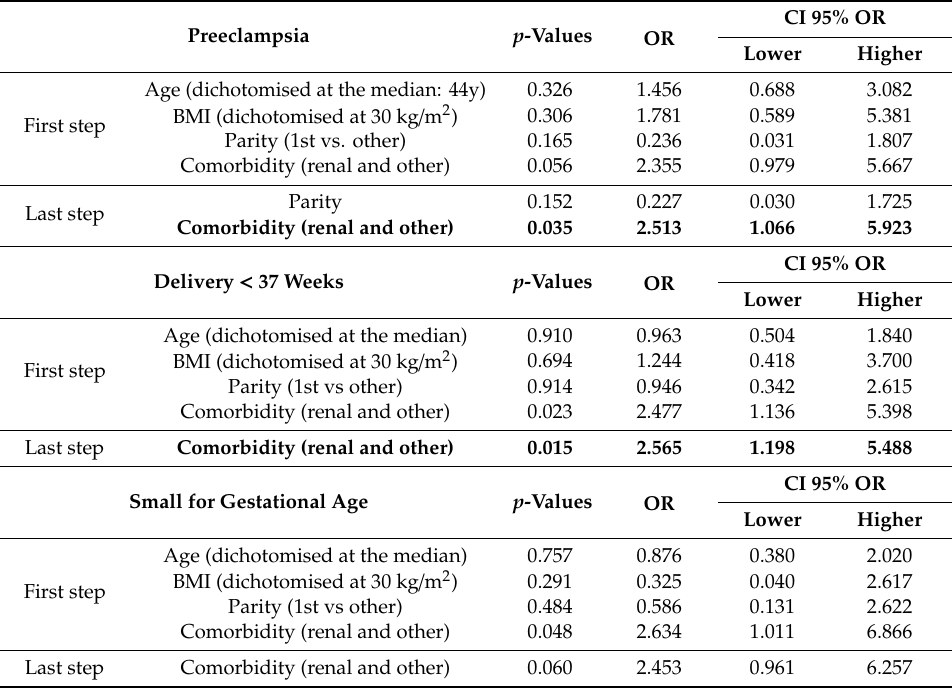
Table 5. Multivariate analysis of di ff erent outcomes: all cases.